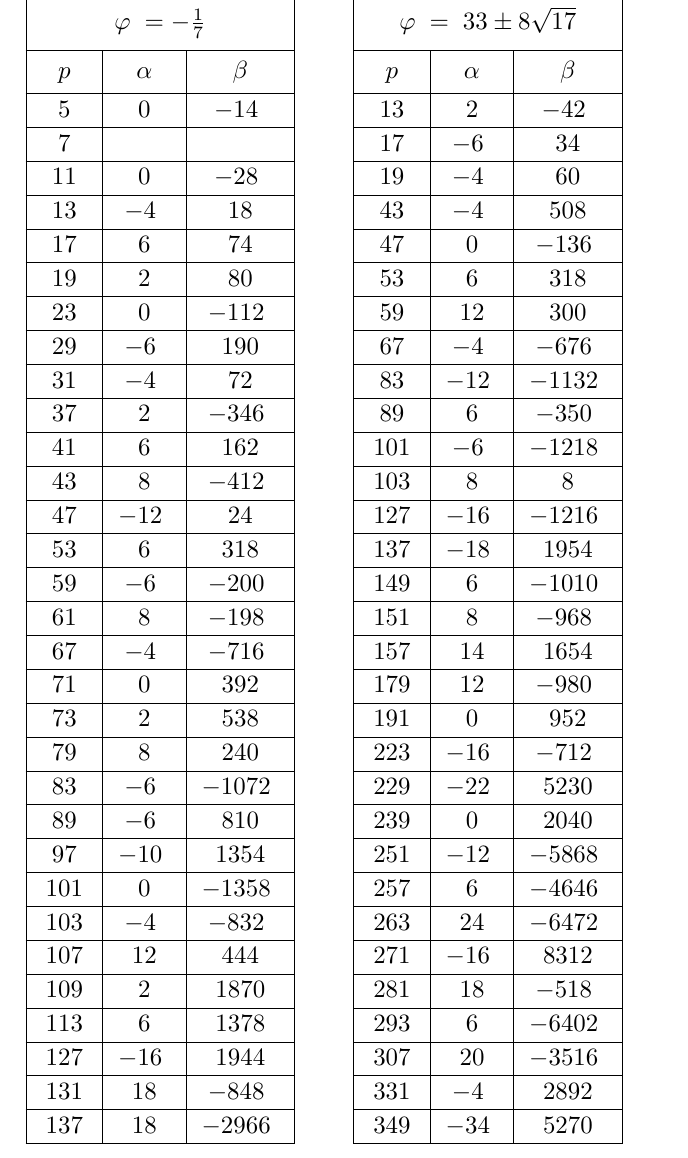
Table 2 . The ( (cid:11); (cid:12) )-coe(cid:14)cients for the attractor points ’ = (cid:0) 1 parameters is in fact correct and that the Hodge numbers for a generic member of the family are given